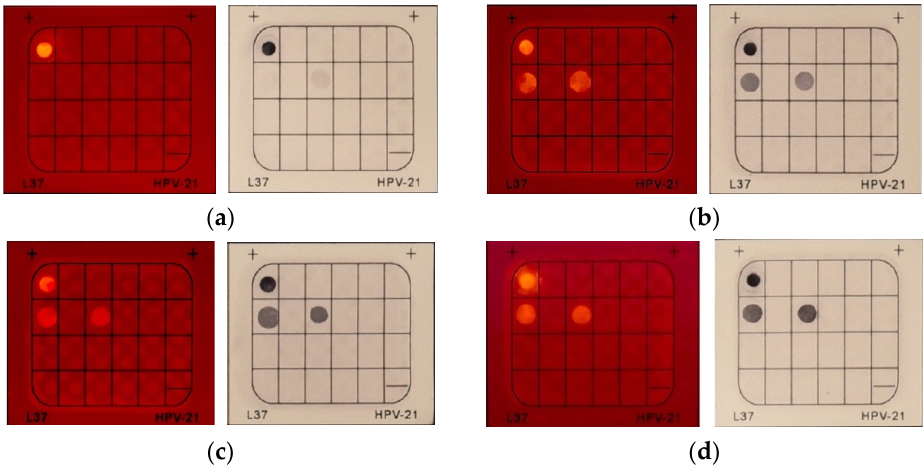
Figure 8. Result comparison of HCAP and BCIP/NBT on the cycles of PCR DNA amplification, showing ( a ) 25 cycles, ( b ) 30 cycles, ( c ) 35 cycles, and ( d ) 40 cycles. [HCAP] = 0.1 mM; probe incubation time: 5 min. Photos were taken under a 395 nm UV lamp with a band-pass filter 600–700 nm for HCAP, while photos were taken under daylight for BCIP/NBT.